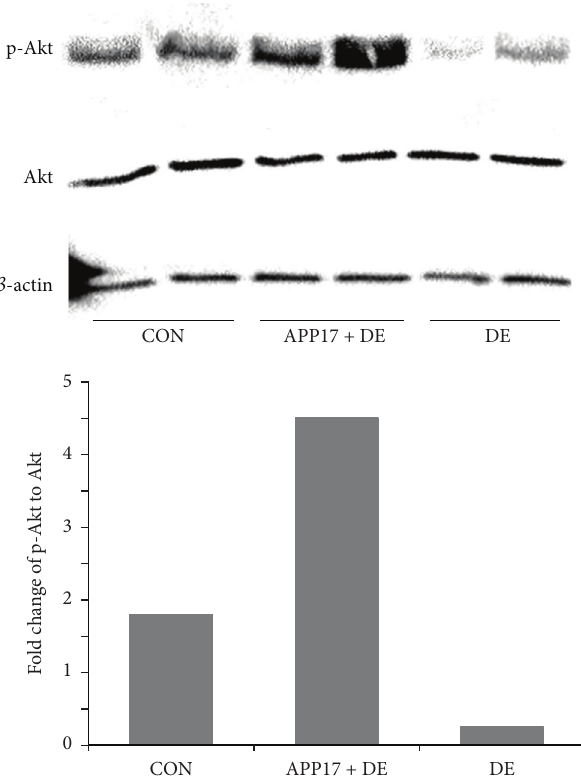
Figure 3: Enhanced insulin-induced Akt activation in the hip- pocampal gyrus of DE rats with APP17